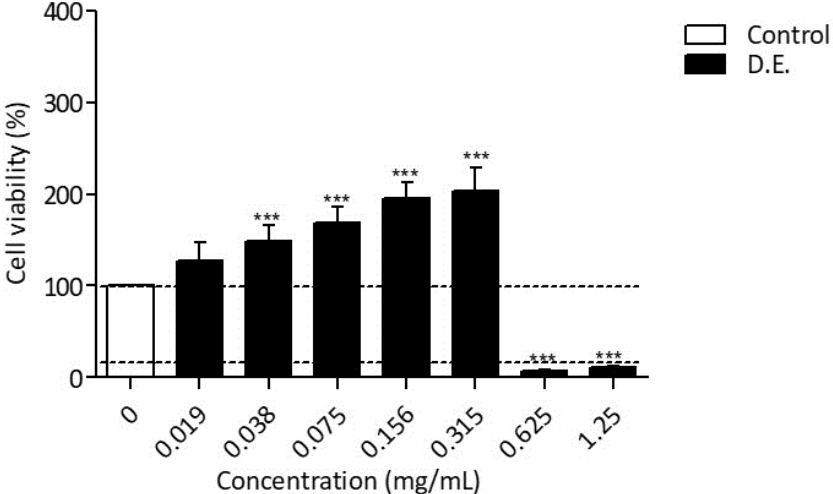
Figure 6. MTT assay on RAW 264.7 cells treated with different D.E. concentrations and incubated for 24 h. RAW 264.7 cells co-treated with lipopolysaccharide (LPS) was used as Control, n = 6 ± SD. Dotted lines indicate 100% and 6%, respectively. *** p < 0.0001, D.E. vs. Control (One-way ANOVA test).